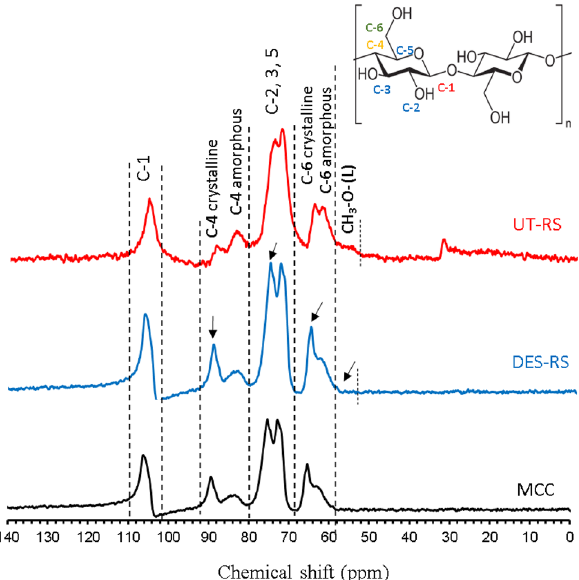
Figure 7. Solid state 13 C CP/MAS NMR spectra of untreated (UT-RS) and pretreated rice straw (DES-RS) in comparison with microcrystalline cellulose (MCC); the arrows show the changes in the cellulose after pretreatment.